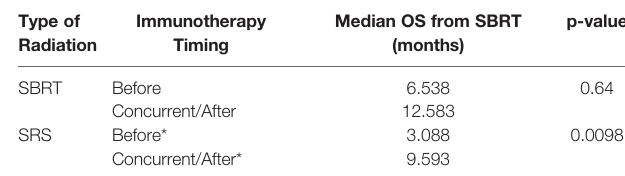
TABLE 5 | Median OS as calculated from the end of radiation treatment based on the type of